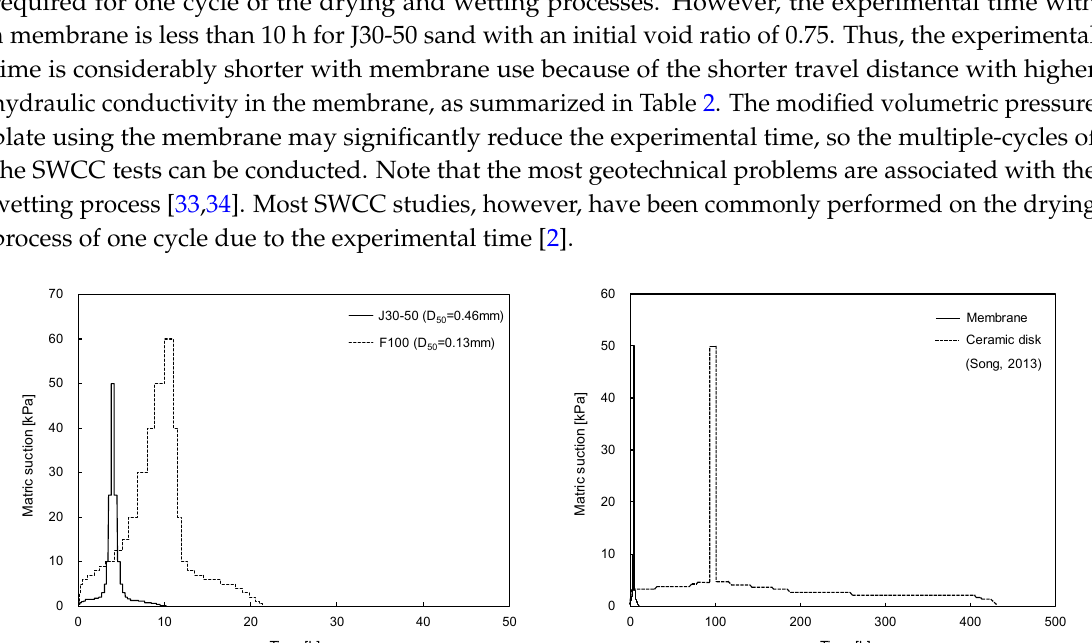
Figure 9. Experimental time for one cycle of the SWCC: ( a ) membrane for J30-50 and F100 sands with an initial void ratio of 0.85; ( b ) membrane and ceramic disk for J30-50 sand with an initial void ratio of 0.75.